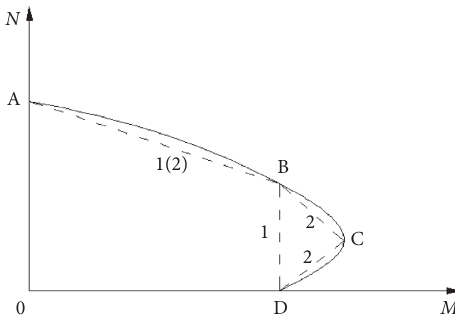
Figure 18: Simplified model of cross-sectional N-M resistance correlation